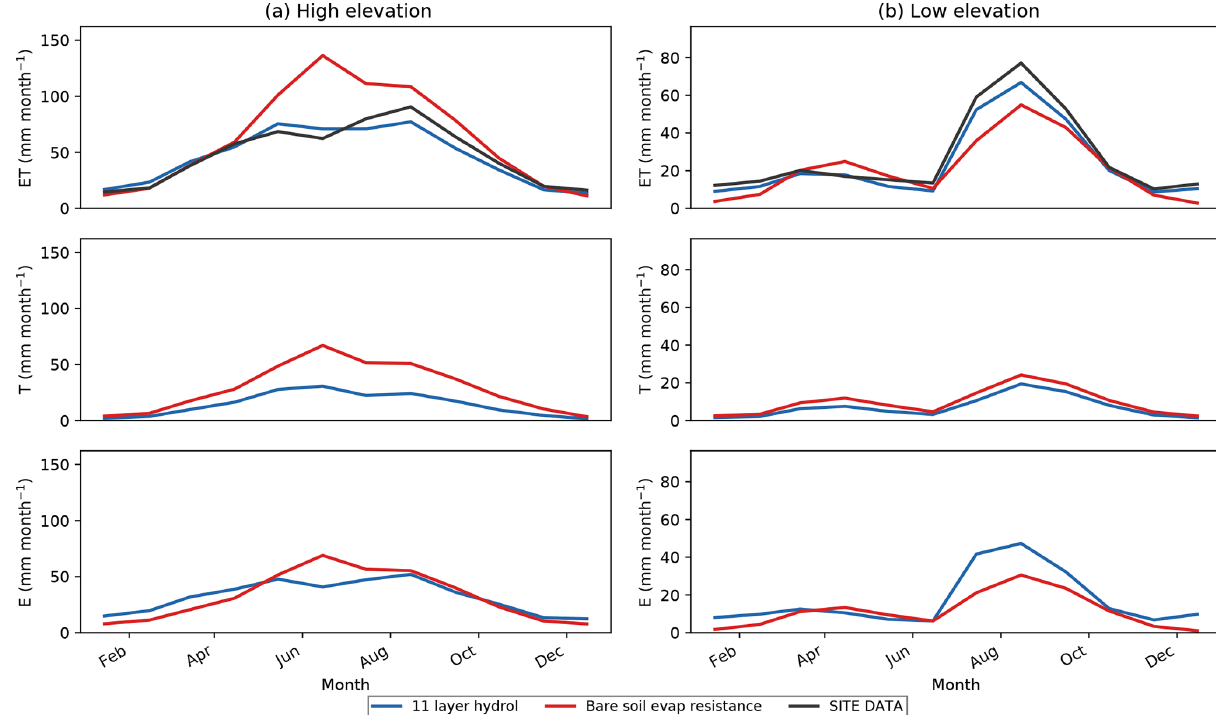
Figure 8. Monthly mean seasonal cycle for evapotranspiration (ET), transpiration, T , and bare soil evaporation, E , averaged across all high- elevation forest sites (a) and low-elevation monsoon grass- and shrub-dominated sites (b) for the default 11LAY simulations (blue curve) compared to a simulation that included an additional bare soil evaporation resistance term (red curve). ET is also compared to observations (black curve). Units are millimeters per month (mmmonth − 1